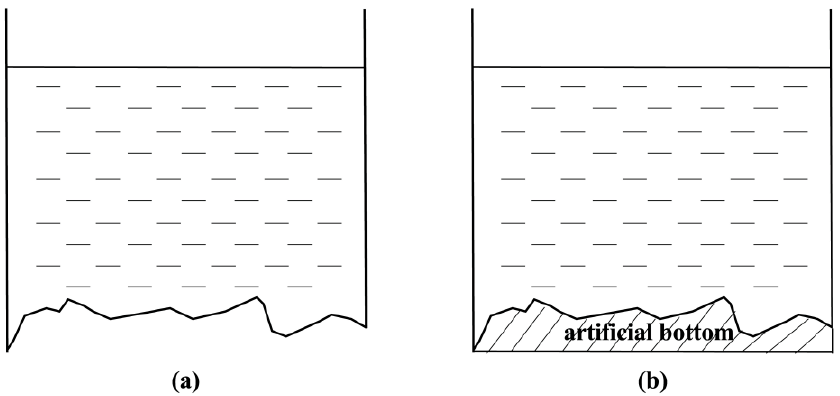
Figure 3. Diagrammatic sketch of the artificial bottom of an irregular wall. ( a ) The computational domain is irregular before the artificial bottom is introduced. ( b ) The irregular computational domain becomes regular after introducing the artificial bottom.